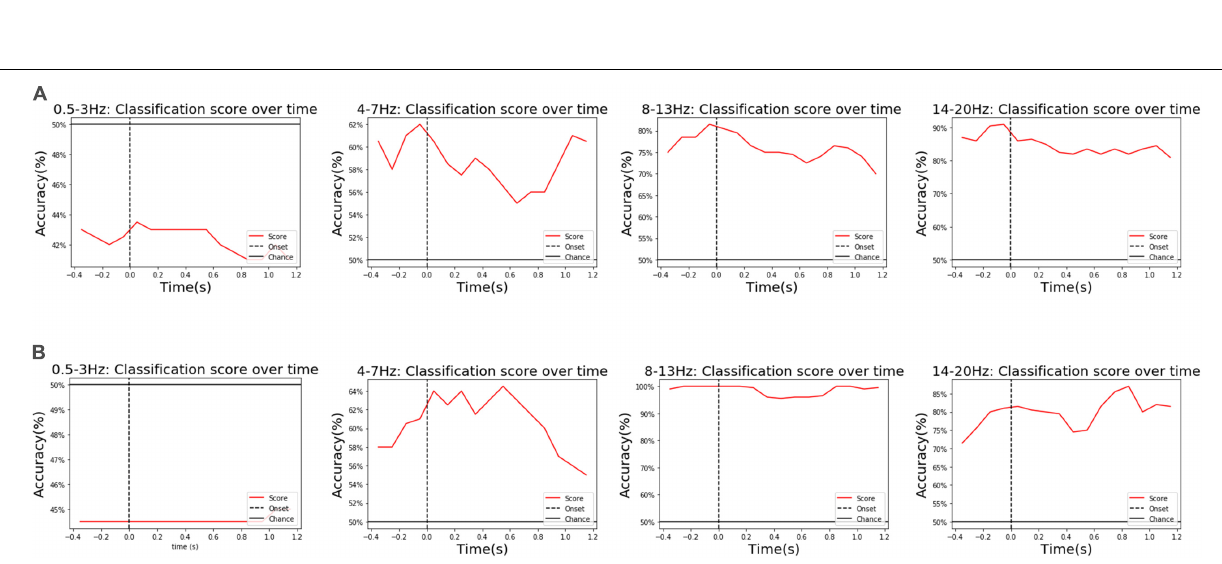
Frontiers in Human Neuroscience |